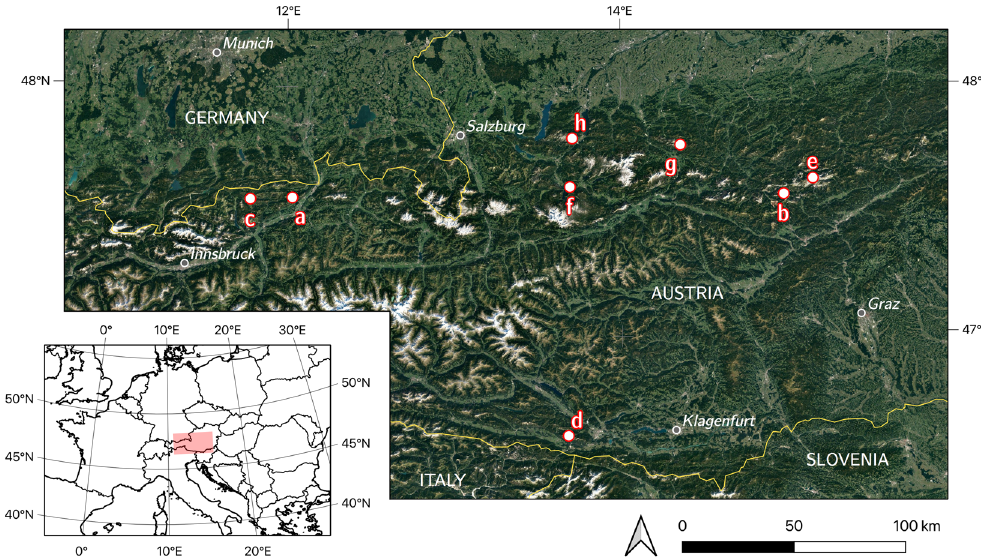
Figure 1. Studied caves in the Eastern Alps of Austria. (a) Hundsalm Eis- und Tropfsteinhöhle, (b) Bärenloch Eishöhle, (c) Guffert Eisschacht, (d) Großer Naturschacht, (e) Tremml-Schacht-413, (f) Eisgruben Eishöhle, (g) Kraterschacht, (h) Hochschneid Eishöhle. Google Satellite